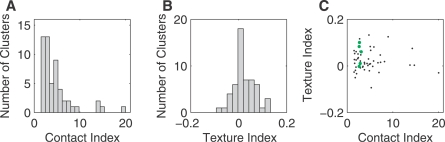
Contact and Texture Indices on Whisker Touch(A) Distribution of the contact index, C. All clusters have C > 1, equivalent to an increase in firing rate on contact.(B) Distribution of texture index, T. Most clusters have T > 0, equivalent to a higher firing rate for rough than for smooth contact.(C) Correlation between contact index and texture index across clusters. The green points are single neurons.